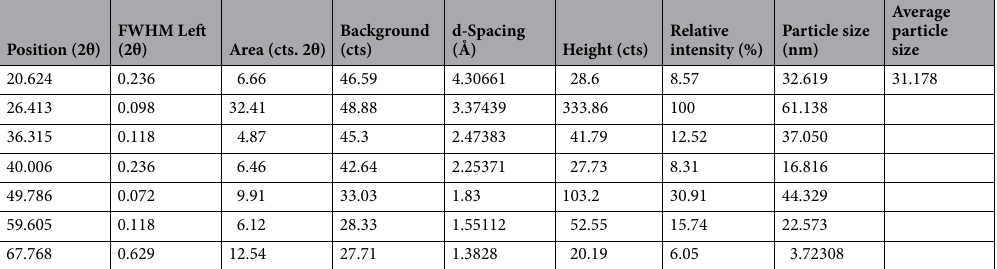
Table 2. XRD spectral analysis details of Fe/SnO/Feldspar (supported nano-magnetic) catalyst.